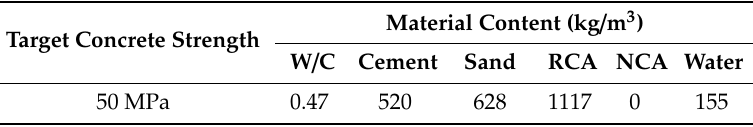
Table 1. The mix proportions of the concrete.